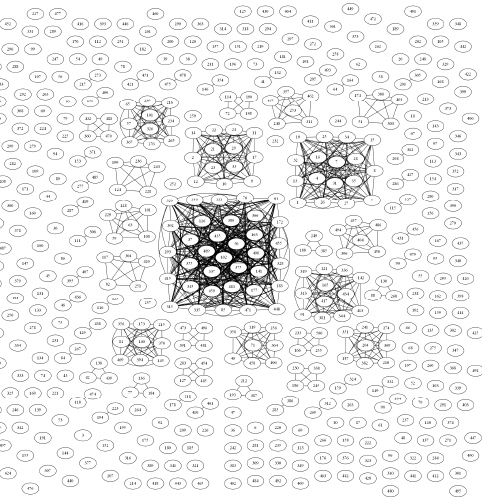
Figure 6. The similarity graph of API calls threshold = 0.4: ( a ) Malware; ( b ) legitimate.